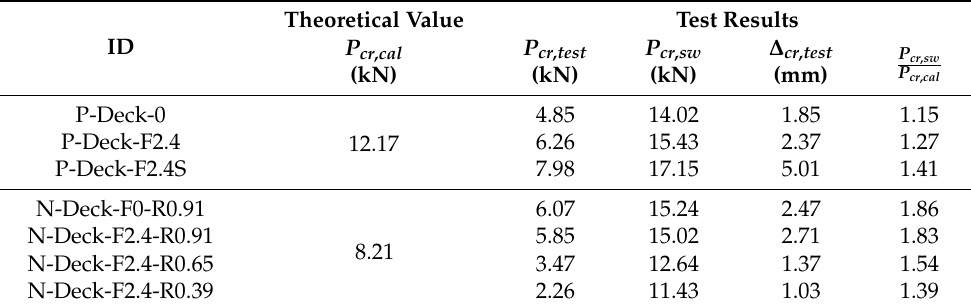
Table 8. Test results of cracking